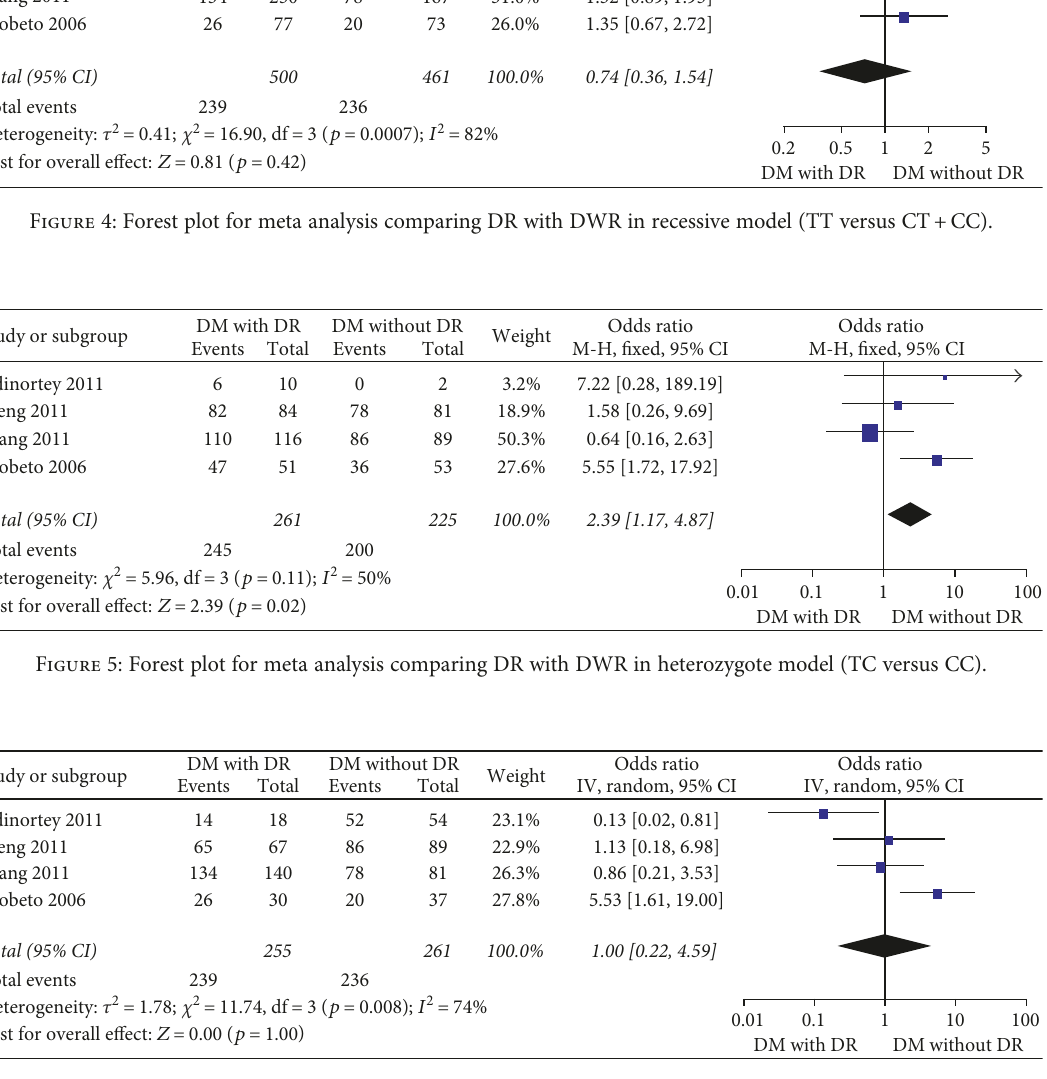
Figure 6: Forest plot for meta analysis comparing DR with DWR in homozygous model (TT versus